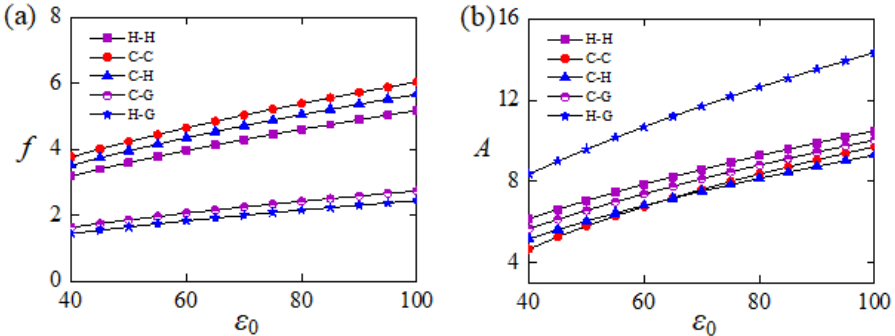
Figure 12. ( a ) Frequency and ( b ) amplitude of the self-buckling for different constraint configuration and light-induced expansion loading. In the computation, β = 0.8, T 0 = 0.5, W 0 = 0.1, and W are set. Generally, strengthening the boundary constraint can increase the frequency and reduce the amplitude.